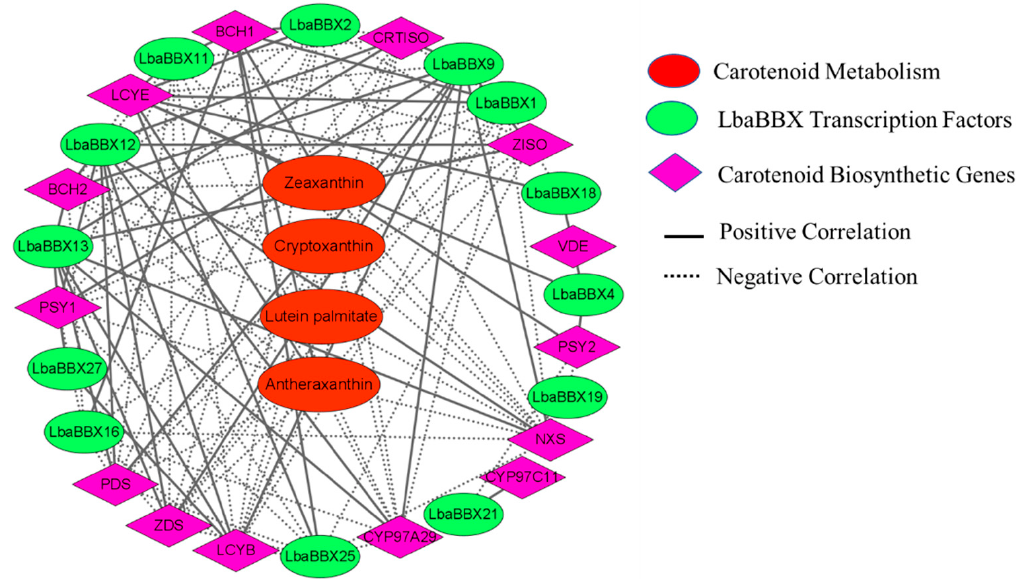
Figure 8. Correlation network analysis for structural genes, LbaBBX transcription factors and carotenoid content. The red ellipse boxes indicated that carotenoid metabolism, the green ellipse boxes indicated that LbaBBX transcription factors, and the purple diamond boxes indicated carotenoid biosynthetic genes, respectively. The black solid lines indicated positive regulation, while the dot lines indicated negative regulation, respectively. The edges are drawn when the linear correlation coefficient is >0.8 with p -value < 0.05. The related correlation coefficients were shown in Table S8.